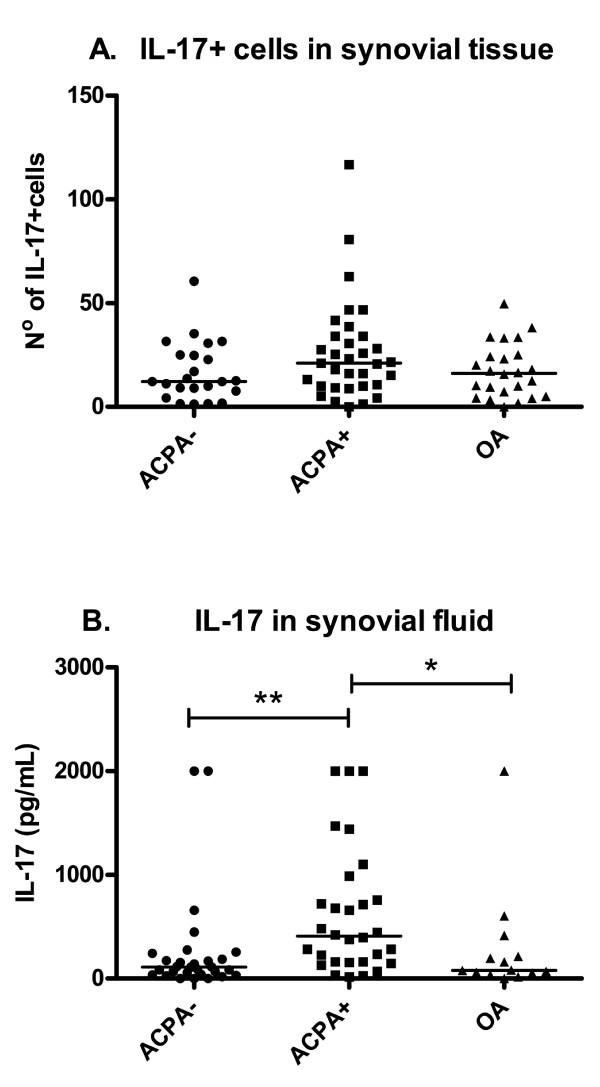
IL-17 in synovial tissue and synovial fluid. (A) Number of IL-17+ cells in synovial tissue of ACPA- and ACPA+ RA and OA patients. The results are expressed as the number of cells assessed in 10 high-power fields at ×400 magnification. (B) Levels of IL-17 in synovial fluid determined by ELISA. *P < 0.05 and **P < 0.01, both indicating statistically significant differences. ACPA, anticitrullinated protein antibody; OA, osteoarthritis; RA, rheumatoid arthritis.